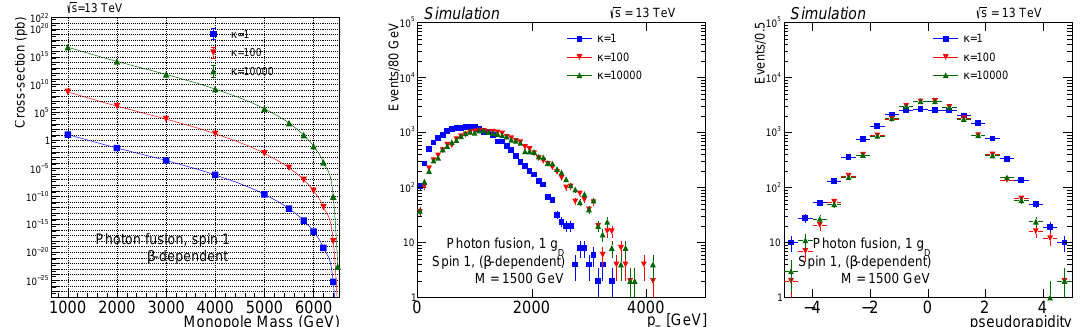
Figure 7. The cross-section variation with the monopole mass at a proton-proton collision energy of 13 TeV is shown on the left plot for the spin 1 monopoles. The transverse momentum ( p T ) distribution ( middle ) and pseudorapidity distribution ( right ) are shown for the spin 1 monopole at a proton-proton collision energy of 13 TeV